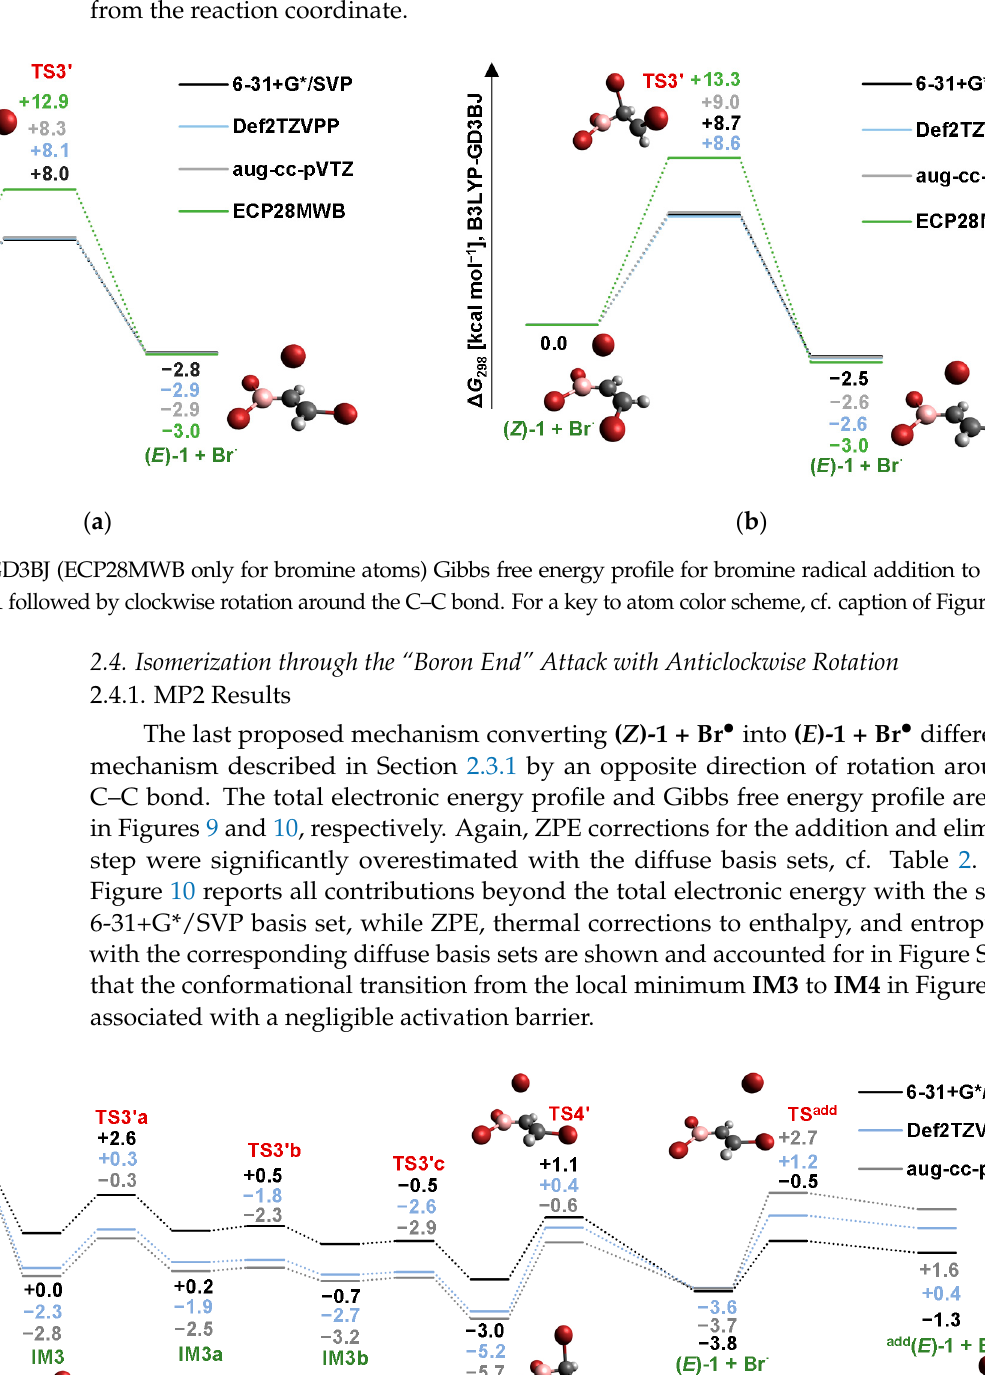
Figure 10. MP2 Gibbs free energy profile for bromine radical addition to the “boron end” of ( Z )-1 followed by anticlock- wise rotation around the C–C bond. Total electronic energies from Def2TZVPP and aug-cc-pVTZ basis sets were corrected by 6-31+G*/SVP contributions. For a key to atom color scheme, cf. caption of Figure 1. 2.4.2. B3LYP Results Like in Section 2.3.2, also in the case of the boron-end attack plus anticlockwise rota- tion, the MP2 reaction profile was successfully accomplished prior to the DFT one. It was then employed for identifying stationary points of B3LYP potential energy surface, which again connected the addition, rotation, and eliminations steps into what was effectively a single-step transformation. Indeed, the barriers between IM3a , TS3 ′ a, and TS3 ′ b were negligibly small. The B3LYP approach thus again simplified the proposed mechanisms, and did so with a smaller activation barrier for this anticlockwise rotation (7 kcal mol − 1 ) than reported in the case of the clockwise rotation (9 kcal mol − 1 , cf. Section 2.3.2) 3. Computational Details 3.1. Starting Structures, PES Stationary Point Determination, and Their Verification Starting structures representing reactants and/or products were prepared and preop- timized using the UFF method within the Avogadro 1.1.1 software [22,23]. The resulting geometries were optimized using ab initio methods and the basis sets specified below.